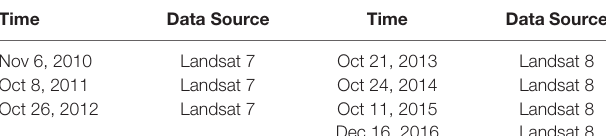
TABLE 1 | The timing of remote sensing of images used in this